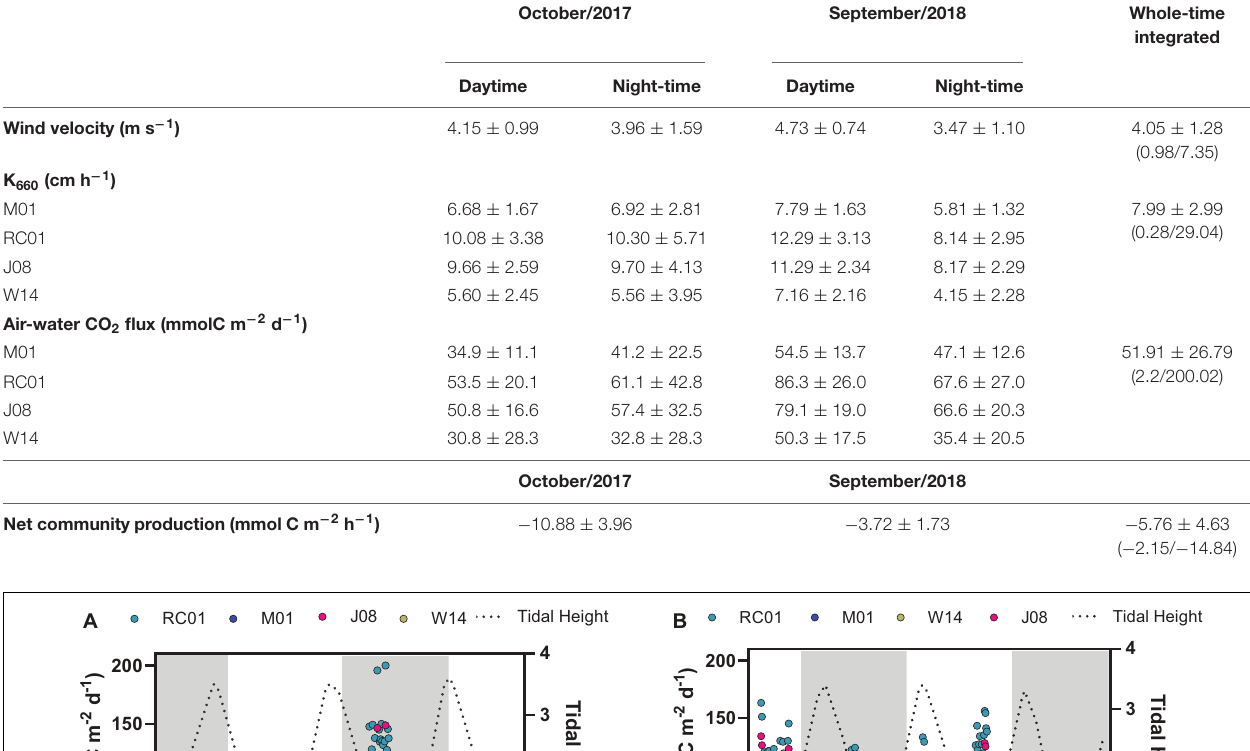
TABLE 2 | Air-water CO 2 fluxes.